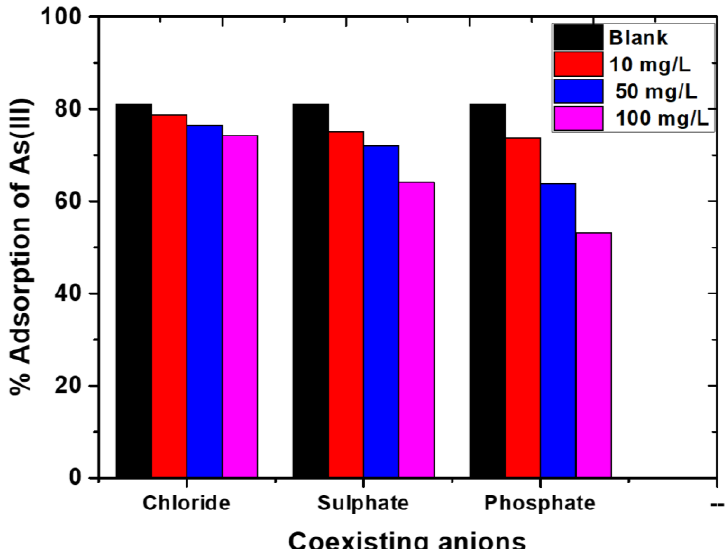
Figure 7. Effect of common coexisting anions on adsorption of As(III) using PP@TiO 2 . (Conditions: Coexisting ions concentration = 10, 50, 100 mg/L; initial As(III) concentration = 25 mg/L; pH = 7; V:m = 1000 mL/g, T = 25 °C, contact time = 24 h).